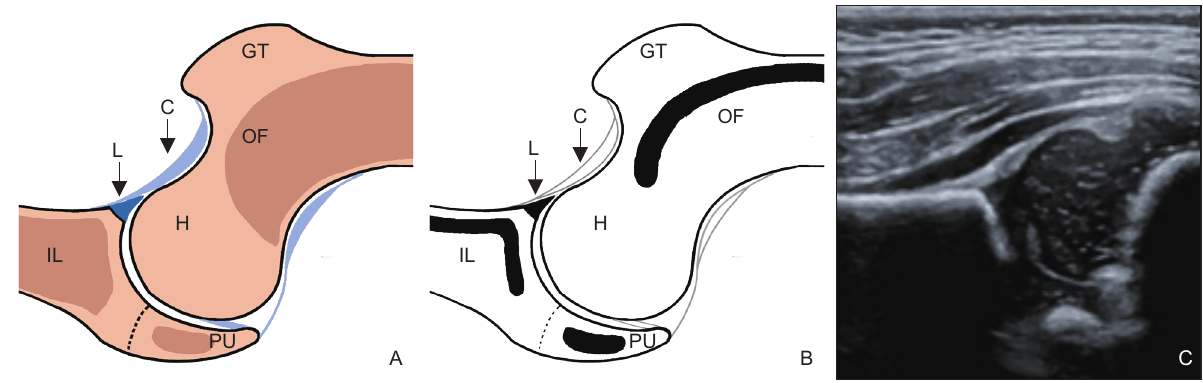
Figure 1 Identify the anatomy of hip ultrasound. (A) Hip anatomy schematic diagram; (B) Coronary section of the corresponding hip ossification: (C) Coronal section image of infant hip. IL, ilium; PU, pubis; H, femoral head; GT, greater trochanter; OF, Ossified end of femur; C, joint capsule; L,